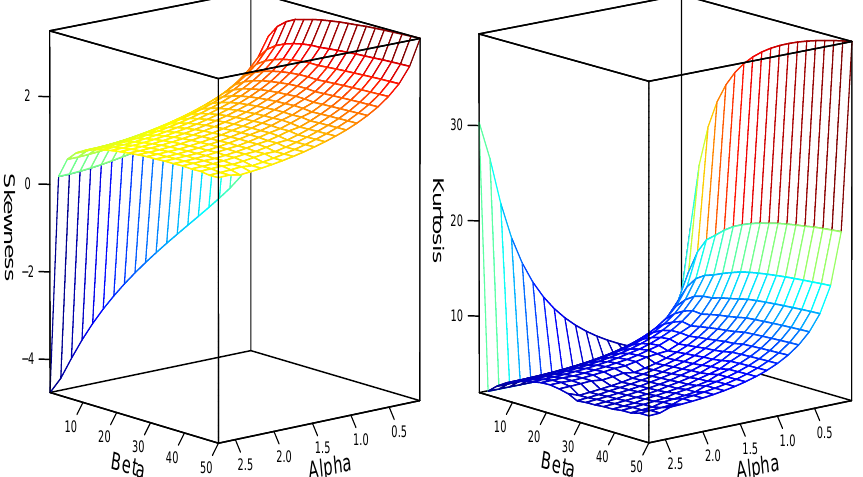
Figure 3. Fisher’s skewness and kurtosis coefficients for the LPHU